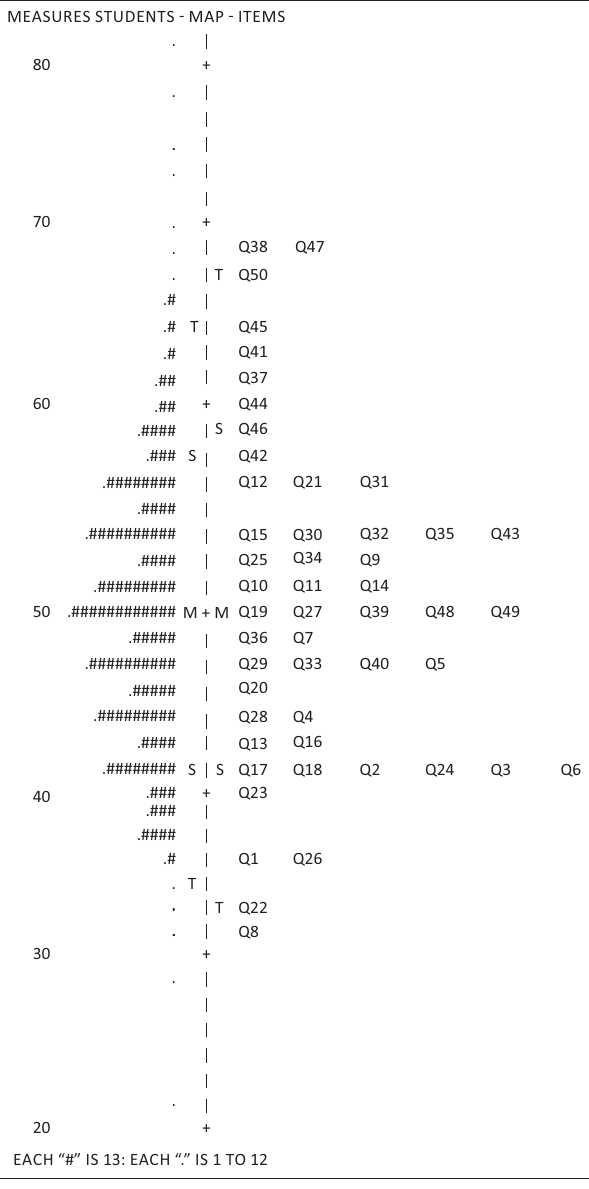
FIGURE 5: PrimTEd mathematics item